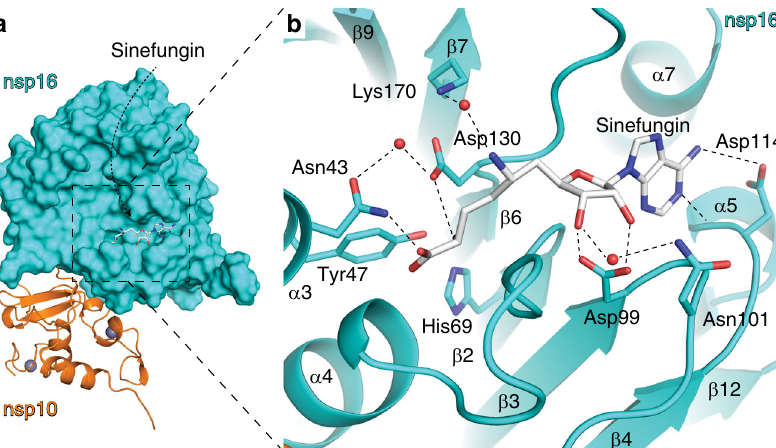
Fig. 4 Sinefungin recognition by the nsp16 MTase. a SARS-CoV-2 nsp10-nsp16 protein complex bound to sinefungin (white sticks), nsp16 in surface representation (cyan), nsp10 in cartoon representation (orange), and zinc ions as gray spheres. b Detailed view of sinefungin recognition, important amino acid residues are shown in stick representation, waters as red spheres, and hydrogen bonds are shown as dashed lines.